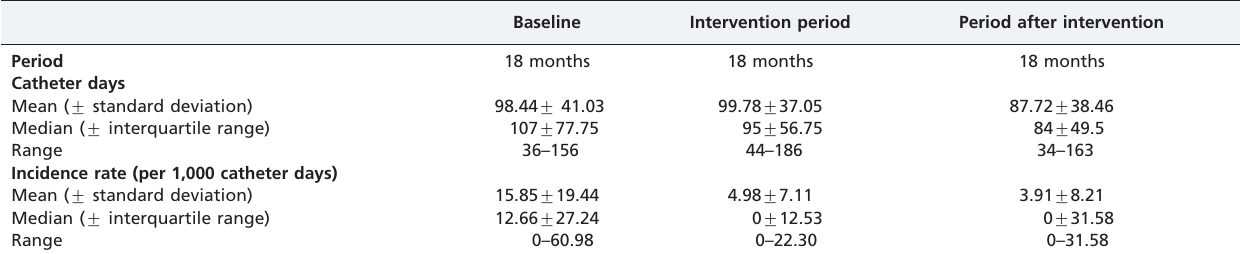
Table 1 - A comparison of the incidence rate and catheter days among the study